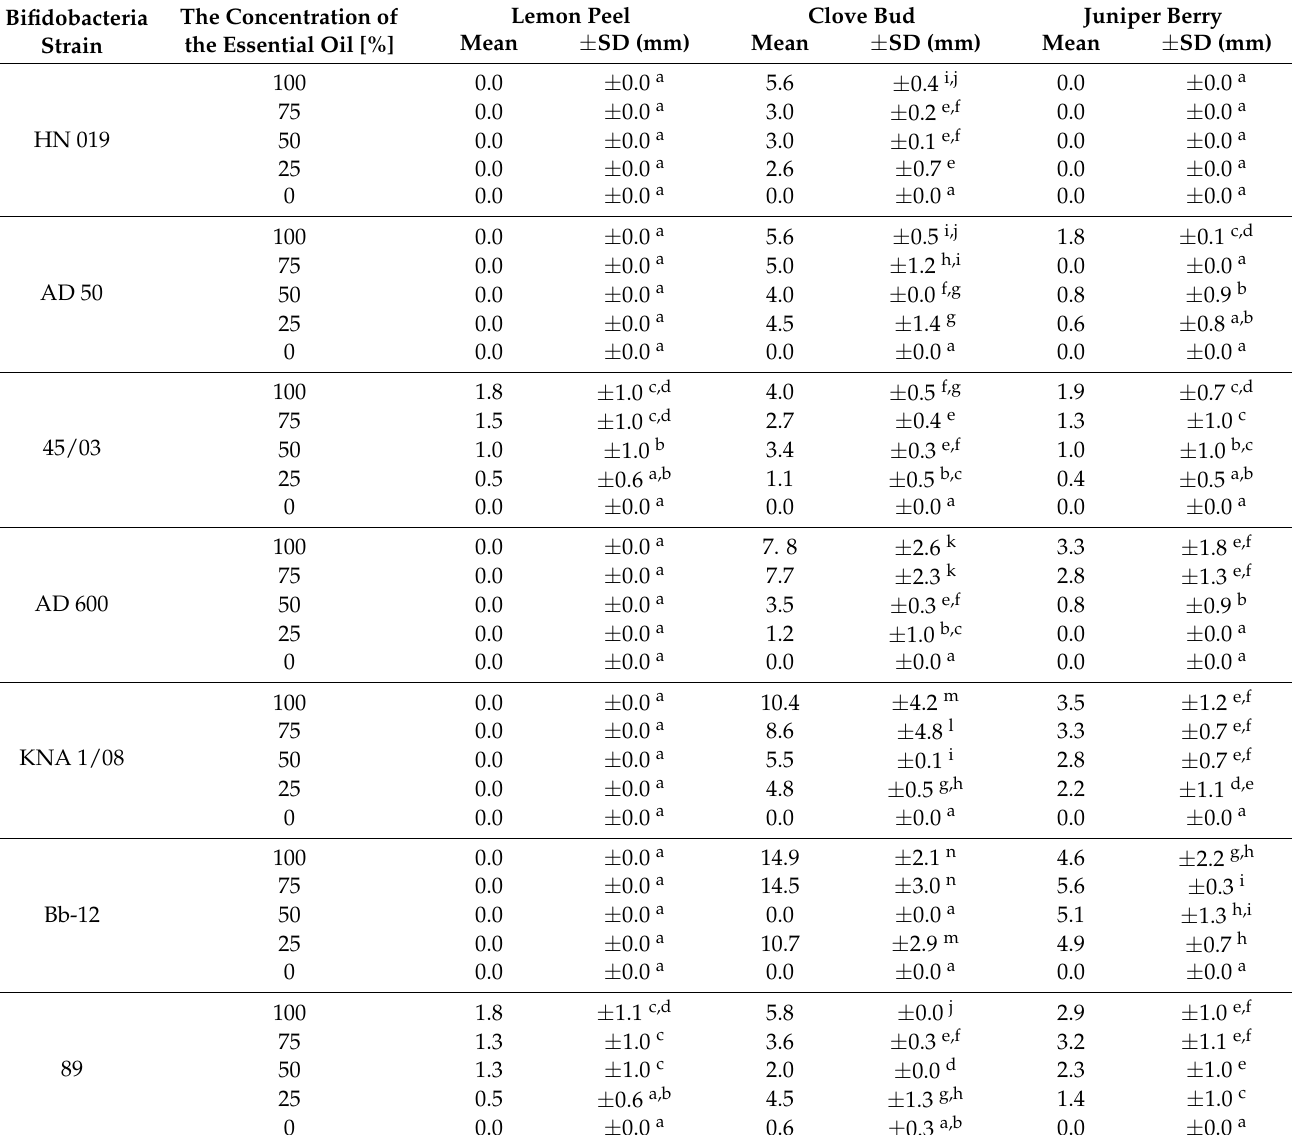
Table 2. Size of the growth inhibition zones (mm) of Bifidobacterium strains observed with selected essential oils (n =